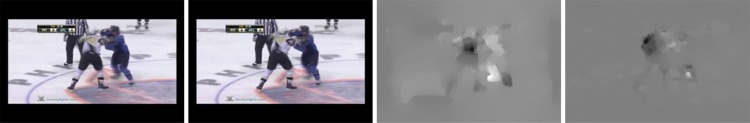
An example of optical flow images.Two consecutive frames, flowx and flowy of the latter frame.